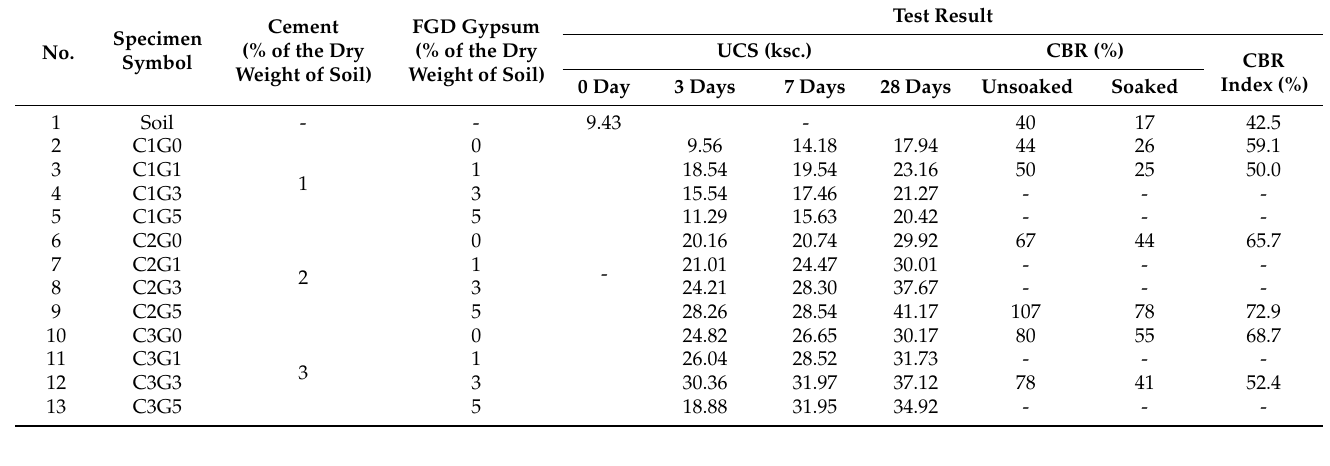
Table 6. Results of unconfined compression strength test and CBR test.